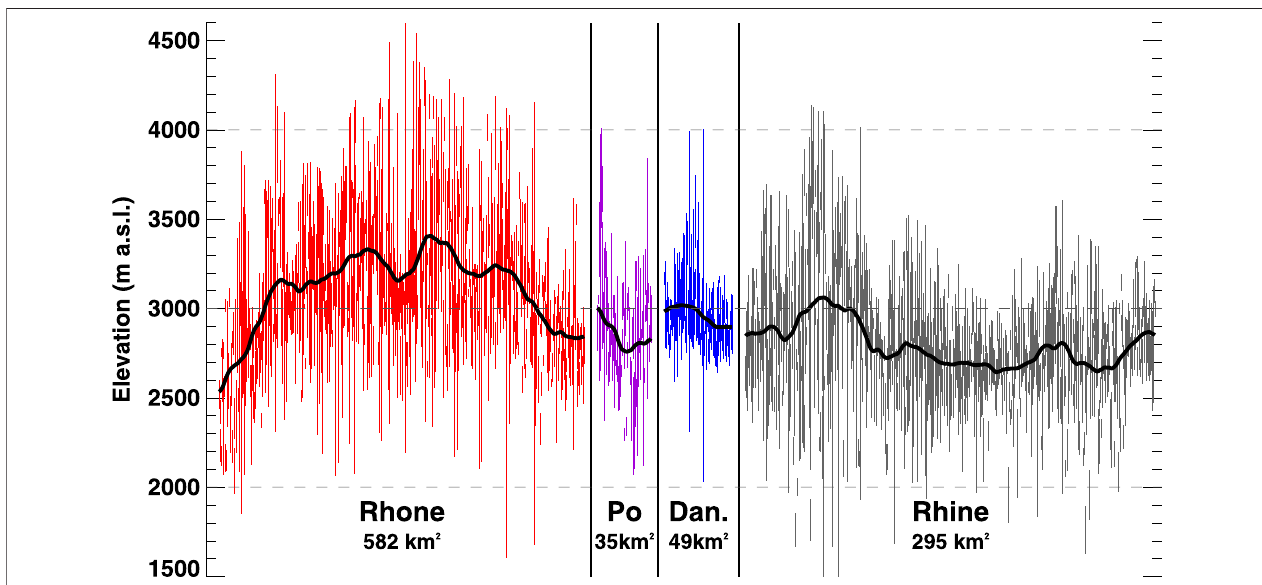
FIGURE 6 | Elevation range of all glaciers in the SGI2016, plotted per major river catchment, ordered from west to east (red, B: Rhone; purple, C: Po; blue E: Danube; grey, A: Rhine). Every colored line indicates the elevation range of a single glacier. The bold black line shows a running mean of the median.